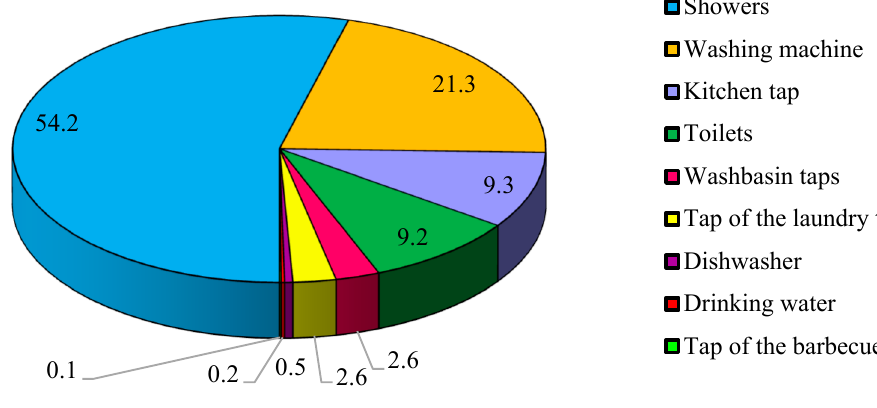
Figure 8. Water end-uses in the flats.